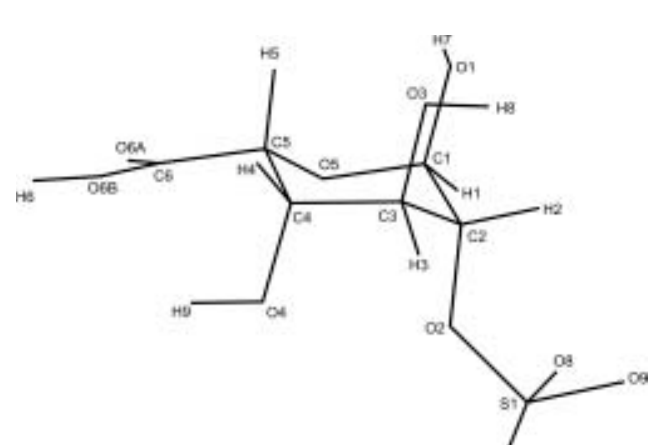
Figure 2b. IdoA2-SO 3- ( 2 S